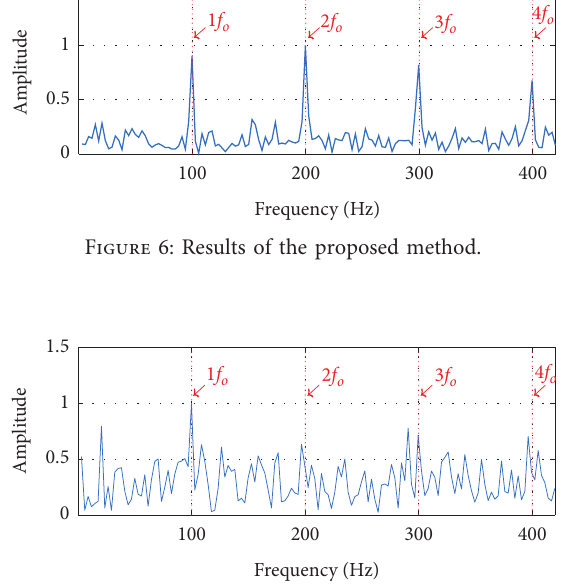
Figure 7: Results of Fast-SC.